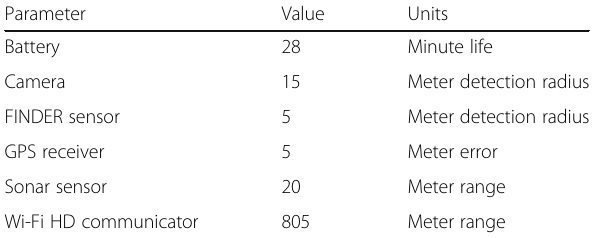
Table 3 Sensors and equipment used in simulation